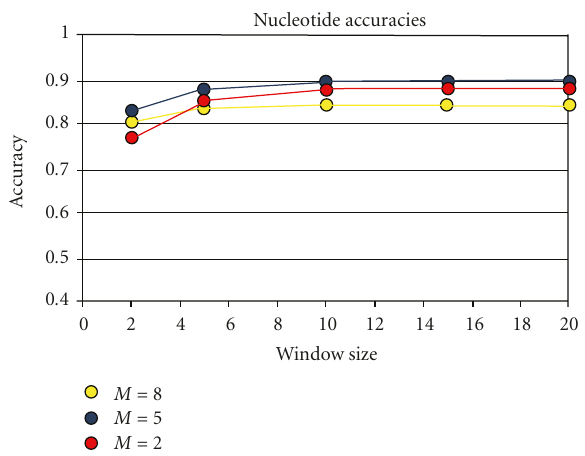
Figure 2: Nucleotide level accuracy rate results with Markov order of 2, 5, and 8, respectively, for C. elegans , Chromosomes